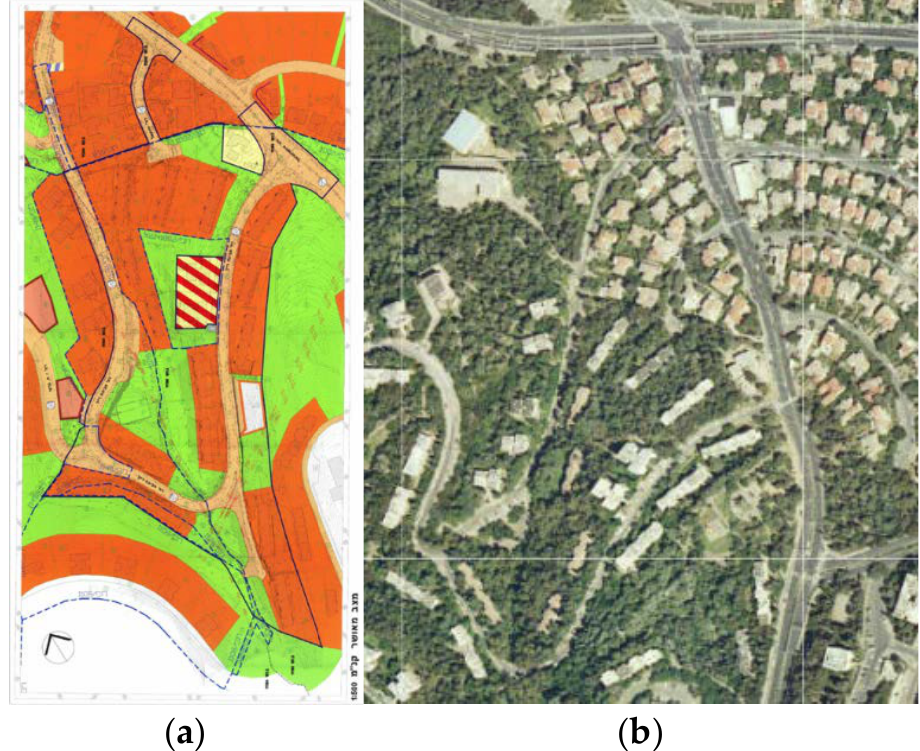
Figure 4. Haviva-Reich site, the approved plan, 2006. Reduction of the public spaces between the buildings (orange: residential housing; green: open areas; brown: public buildings). The design: Giora Gur Architects. Source: the Israeli “Available Planning” website (The Planning Administration,